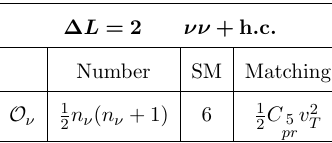
Table 9 . Dimension-three ∆ L = 2 Majorana neutrino mass operators in LEFT. There are also † Hermitian conjugate ∆ L = 2 operators , as indicated in the table heading. The second column ν − O is the number of operators for an arbitrary number of neutrino flavors n ν , and the third column is the number in the SM LEFT with n ν = 3. The last column is the tree-level matching coefficient in SMEFT. ∆ L = 2 ( νν ) X + h . c .